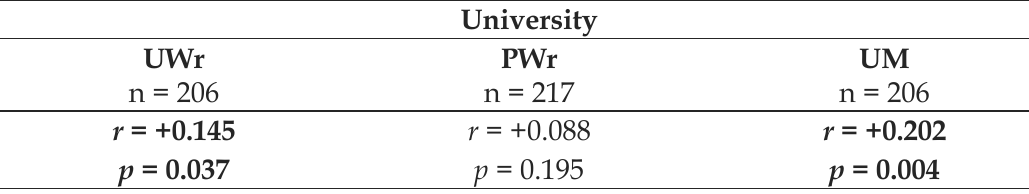
Pearson correlation coef (cid:192) cients SPM “lifestyle” students from SPM “health